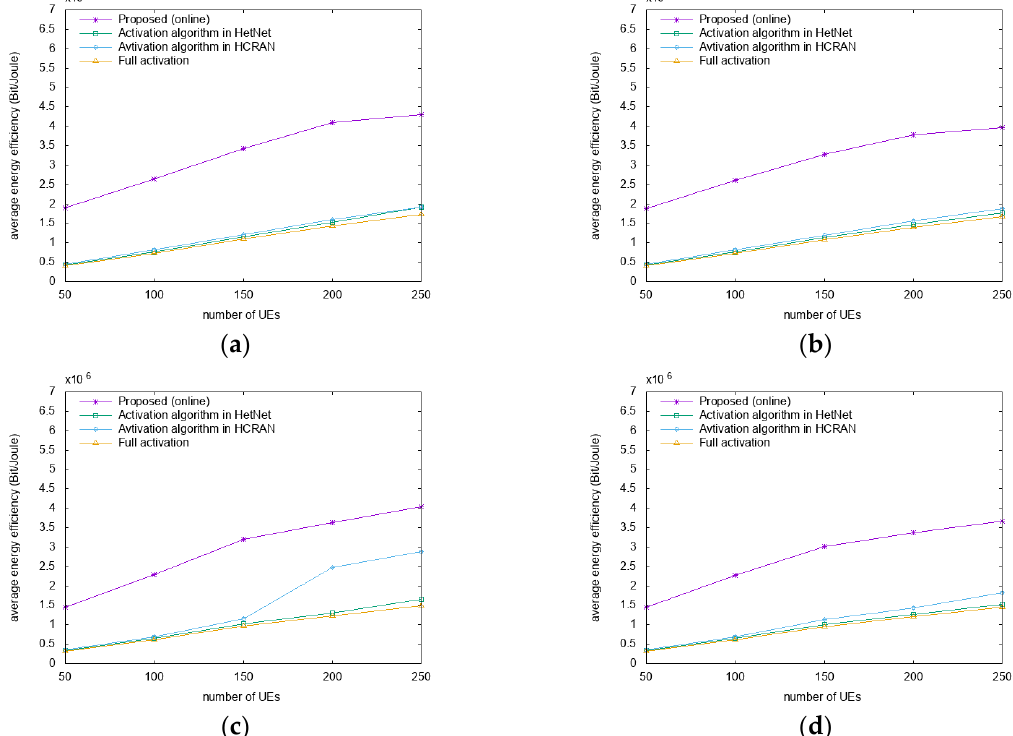
Figure 6. Comparison of the energy efficiencies in environments with 15 RRHs. ( a ) San Francisco and ( c ) Beijing datasets with Gaussian distributions; ( b ) San Francisco and ( d ) Beijing datasets with uniform distributions.